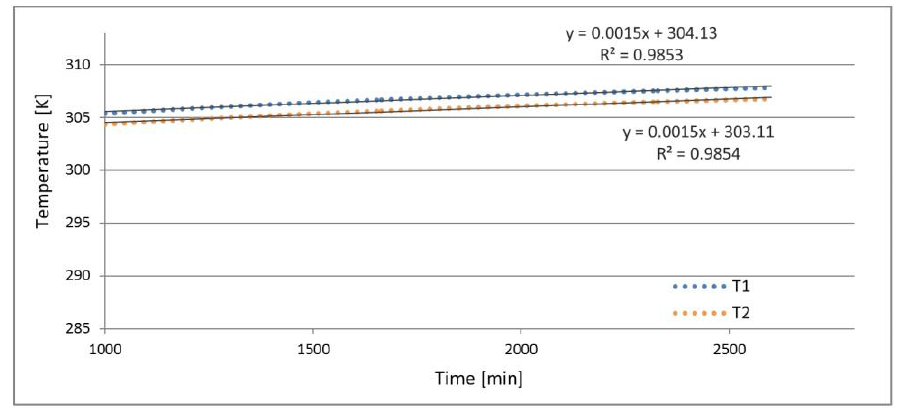
Figure 9. Equation of the linear approximation to temperature registers from time = 1000 min.